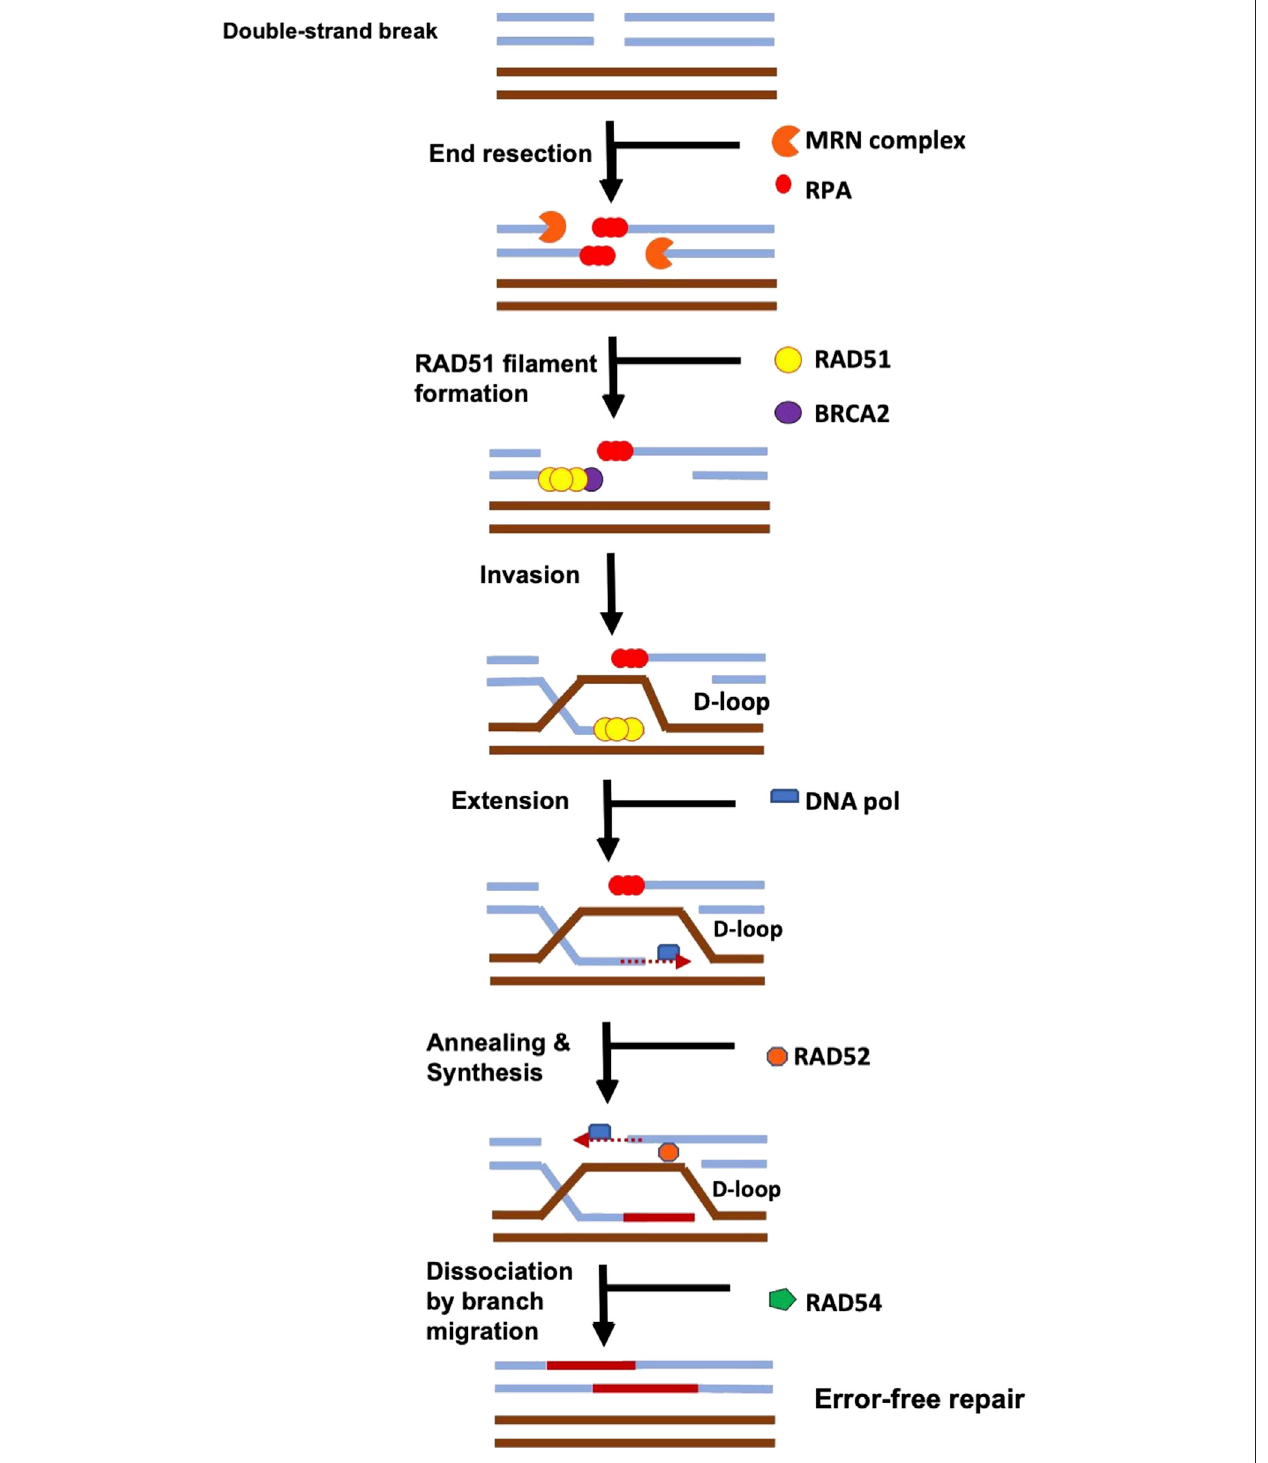
FIGURE 1 | The signalling of a DSB is initiated via the binding of the MRN complex which initiates resection. During HR, the ends ofthe double-strand break (DSB) areresectedbynucleases,exposingsingle-strandDNA(ssDNA)thatbecomesboundbyRPA.Themediatorprotein,BRCA2initiatestheloadingofRAD51ontossDNA, helping to displace RPA. RAD51 oligomerizes, forms a nucleoprotein fi lament, and then searches for the homologous DNA sequence on the intact chromosome. RAD51 fi lament invades the intact dsDNA and forms a D-loop structure. It is further processed by DNA polymerases, chromatin remodelers (RAD54), nucleases, and ligases to restore it back to its original sequences. (Adapted from (Rossi et al., 2021).